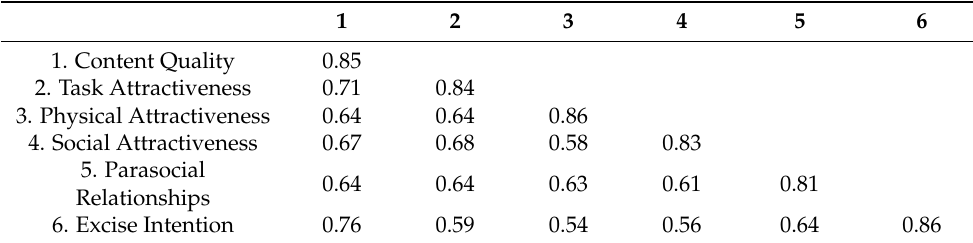
Table 3. Discriminant validity test.